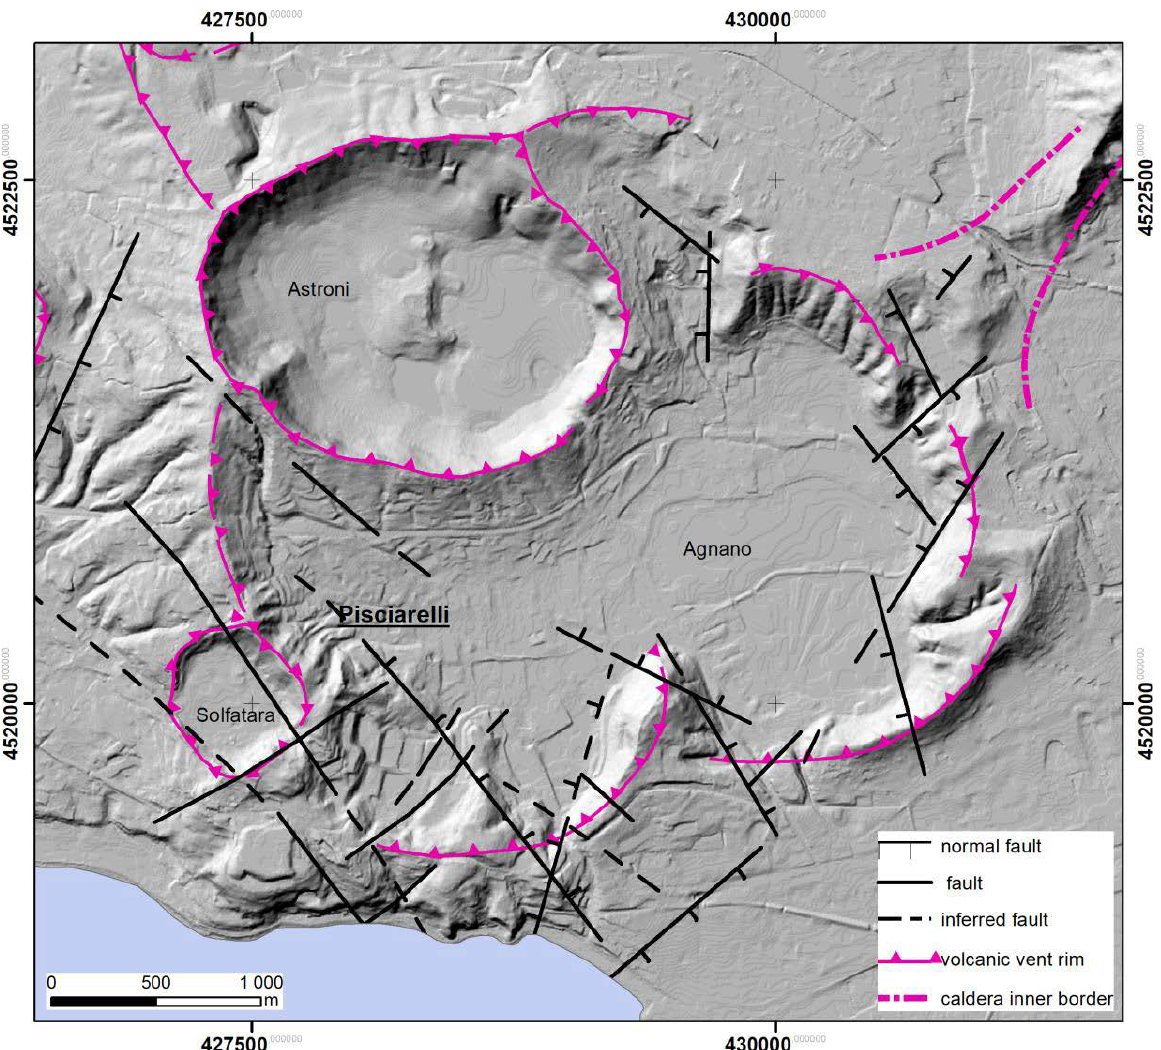
Figure 2. Study area volcano-tectonic framework. Volcanic and tectonic elements are modified by Rosi and Sbrana [37]. The used coordinate system is WGS84/UTM zone